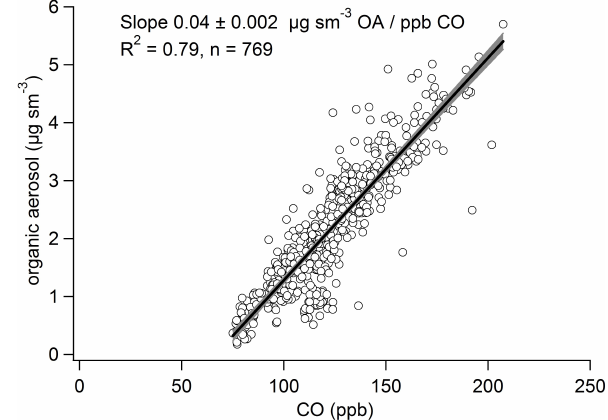
Fig. 3. Correlation of CO to organic aerosol (OA) during both me- terological periods at BEARPEX. The OA data was filtered for ace- tonitrile > 0.175ppb to remove the influence of biomass burning sources of OA. The CO data was filtered by windspeeds > 1ms − 1 to remove generator spikes that influenced the site under stagnant conditions. The OA data has been converted to µgsm − 3 (at 273K and 1atm) for consistency with previous studies (Cubison et al., 2011; DeCarlo et al.,